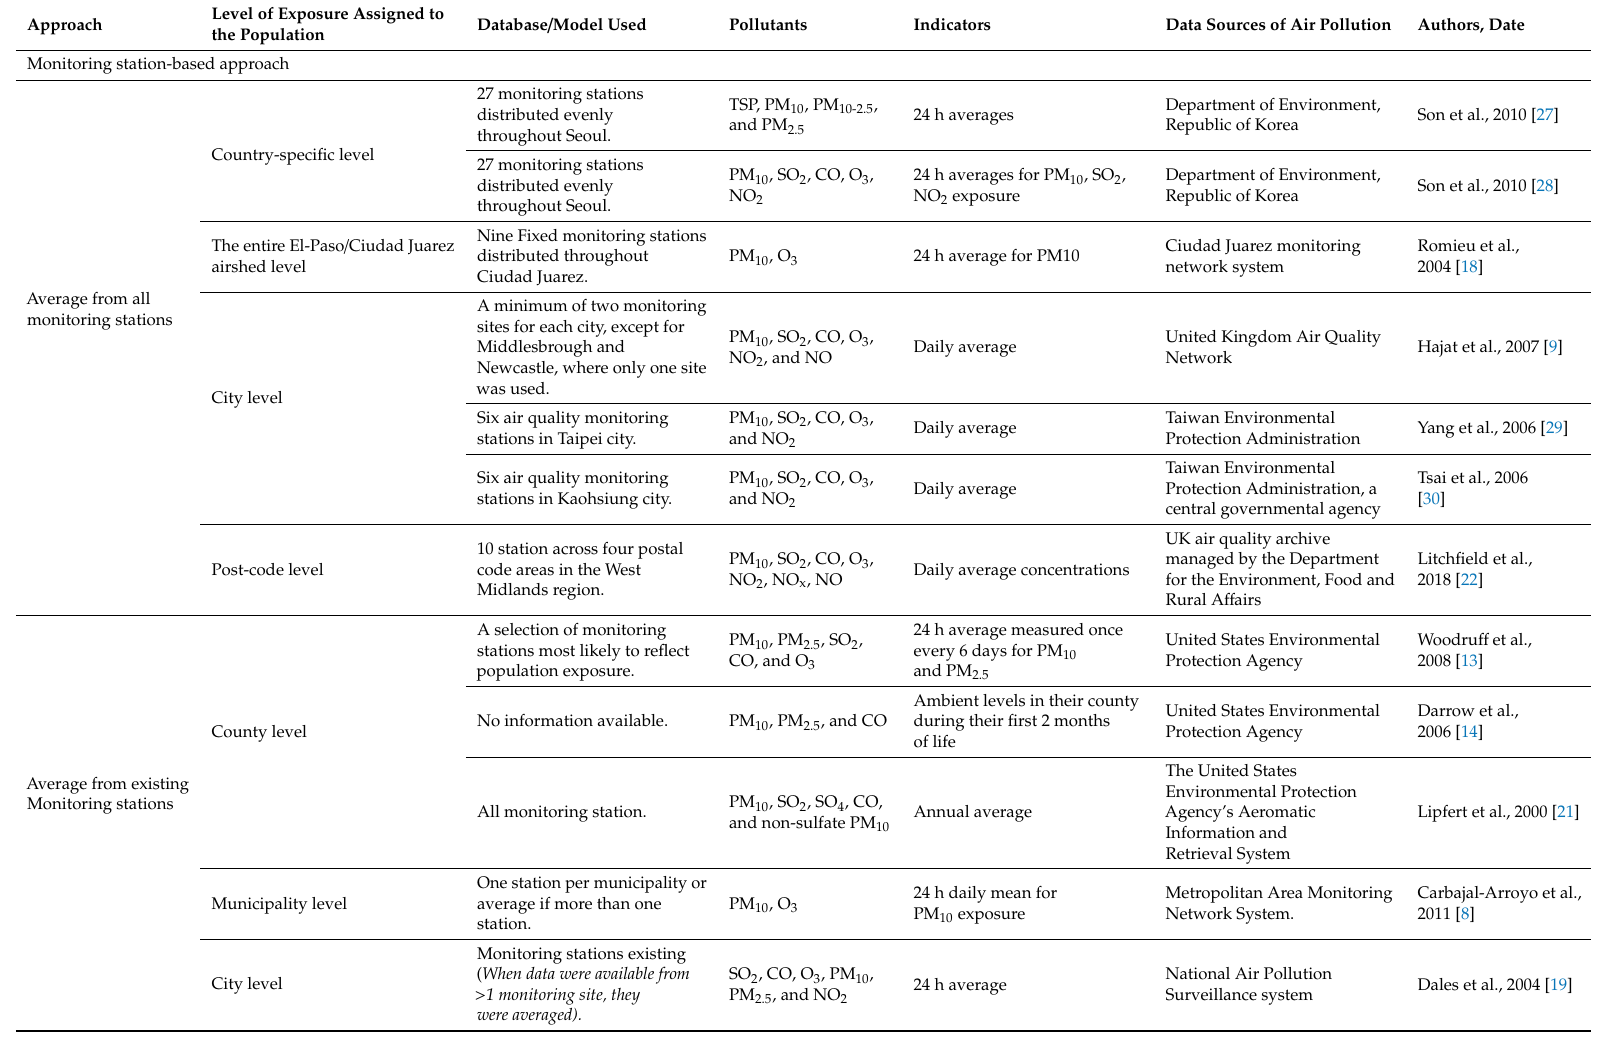
Table 2. Summary of approaches used to assess the residential exposure